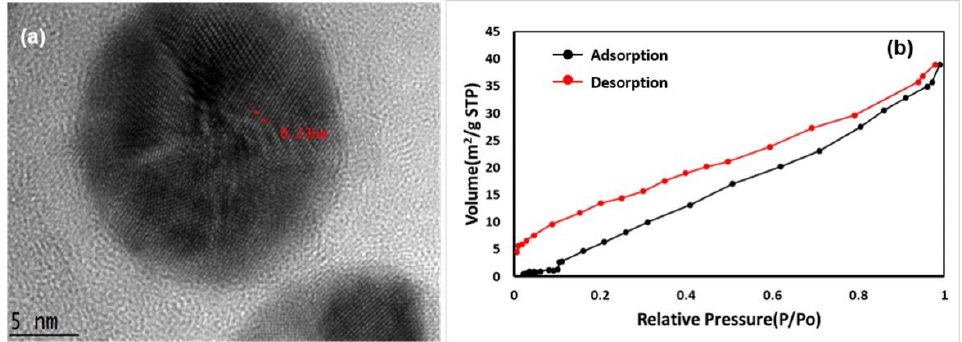
Figure 4. Transmission electron microscopy images of zinc oxide nanostructures ( a ), BET adsorption-desorption isotherms of resultant zinc oxide nanostructures ( b ).